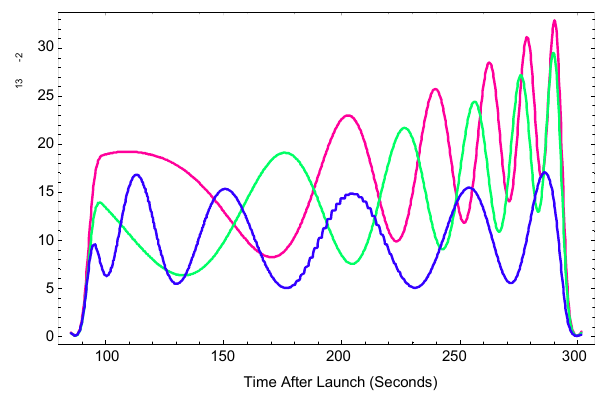
Figure 12. Synthetic TEC for receivers located at ends of the (A) red, (B) green, and (C) blue paths in Figure 11. The corresponding observational data with the same geometry is Fig. 12. Synthetic TEC for receivers located at ends of the (A) given in Figure 3a for the (A) Tarumizu and (B) Uchinoura stations. red, (B) green, and (C) blue paths in Fig. 11. The corresponding The TEC data computed for the E layer model is shown in Figure 12. This data set is observational data with the same geometry is given in Fig. 3a for used with the same algorithm that processes the measured SEEK2 DBB data. The red the (A) Tarumizu and (B) Uchinoura stations. and green curves in Figure 12 can be compared to the red and green curves in Figure 3a with the actual measurements. The slant TEC in Figure 12 increases with time as the radio beacon paths become more oblique. In contrast, the slant TEC in Figure 3a decreases with time indicating a substantial reduction of E-region TEC down range from the launch point. The blue curve in Figure 12 represents the “fictitious” TEC obtained from a receiver point located at point (C) in Figure 11. The initial tests of the thin layer tomography algorithm only use the two sets of synthetic data from the receivers at points A and B. To optimize the reconstructions, several data sampling periods and several grid cell sizes were used. The number of samples per receiver was selected as 106, 541, or 1081. This corresponds to data sample rates of 0.5,